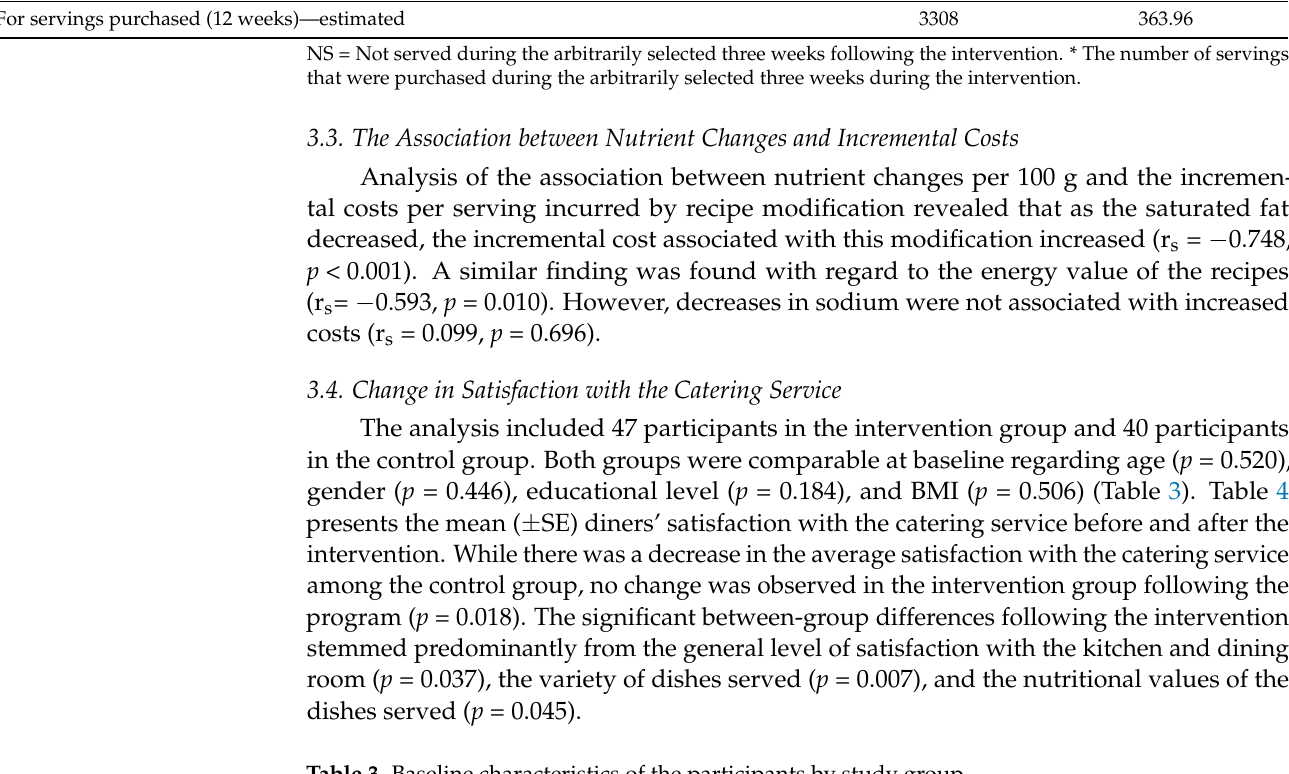
Table 3. Baseline characteristics of the participants by study group.